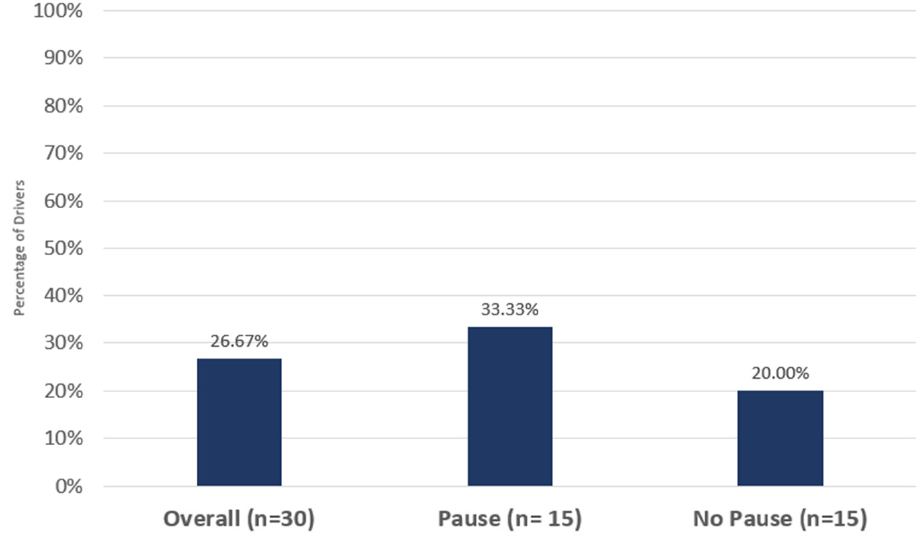
Figure 6. Percentage of drivers observed to initiate precautionary behaviors in response to the lead vehicle hazard lights.